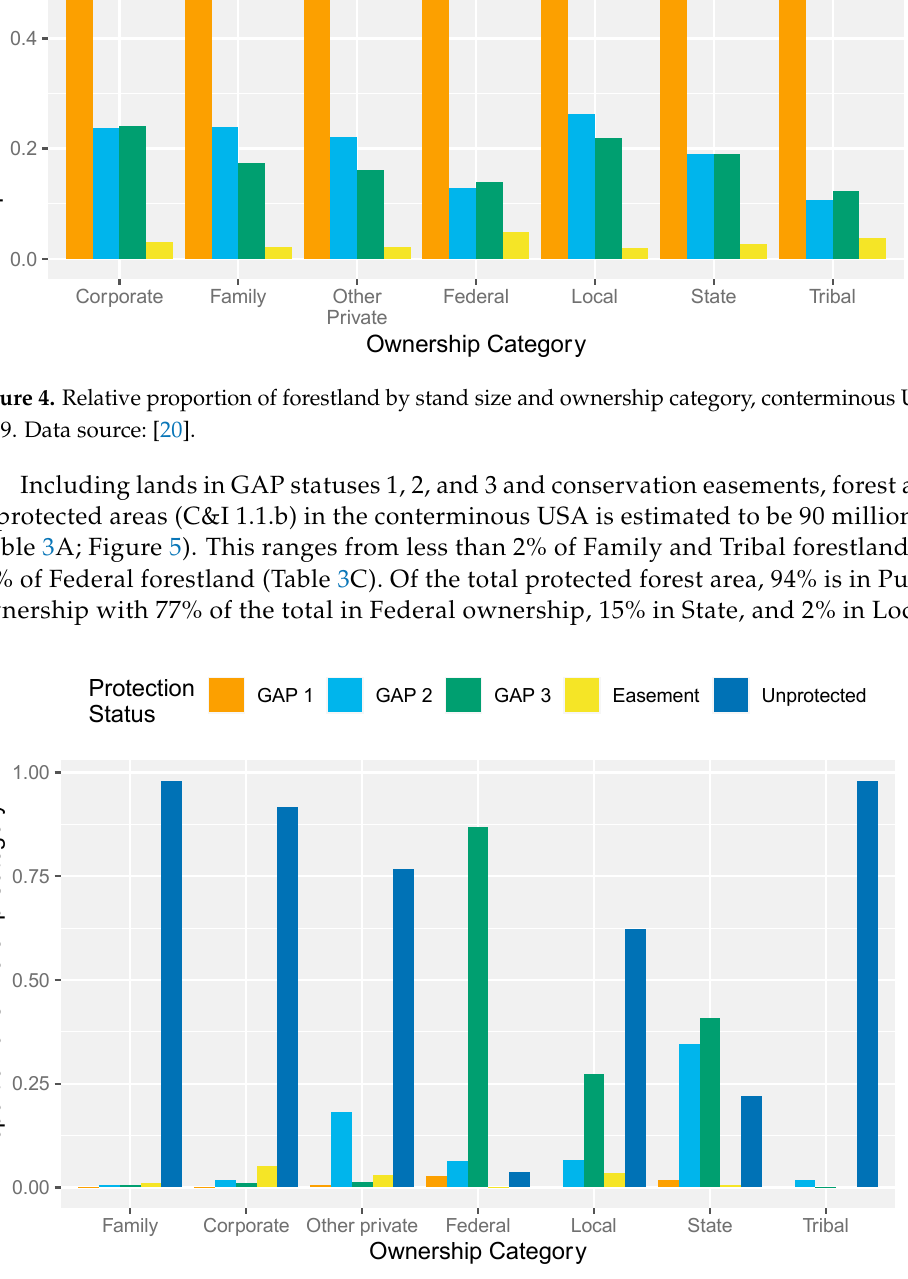
Figure 5. Relative proportion of forestland by protection status and ownership category, conterminous USA, 2019. Descriptions of the protection status categories are included in the methods section. Data source: [16].